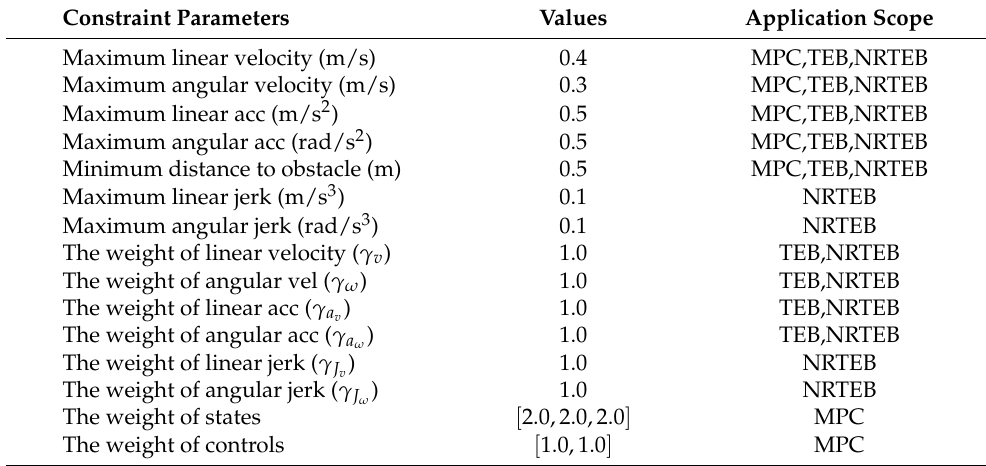
Table 1. Kino-dynamic parameters and optimization